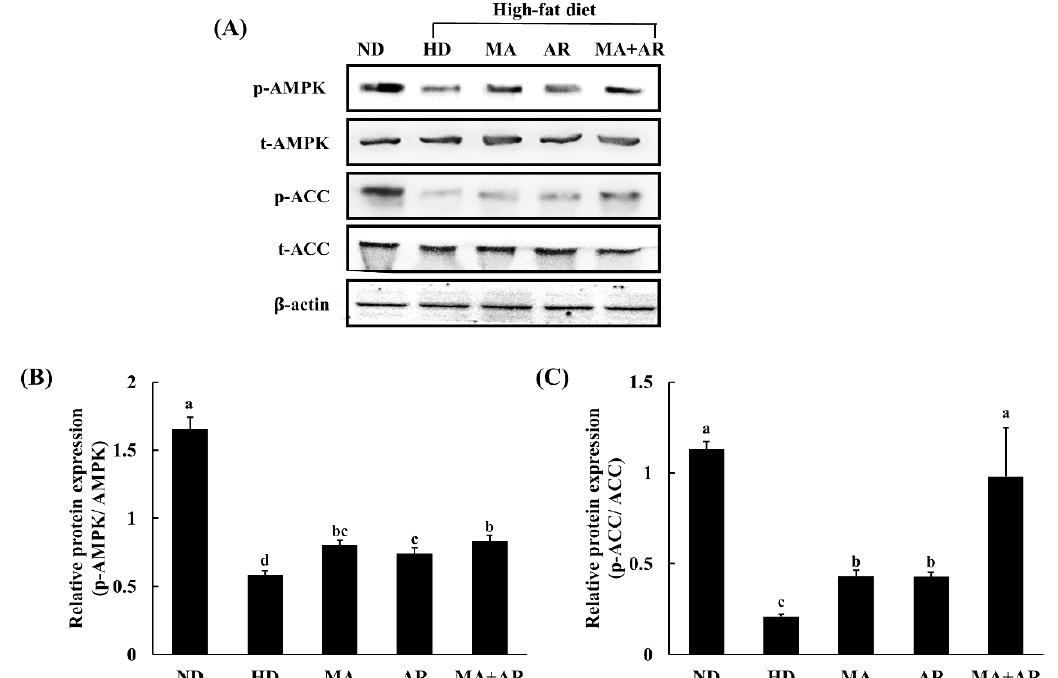
Figure 6. Proteins involved in lipid metabolism in the liver of the experimental mice. M. alba extract (400 mg/kg b.w), A. melanocarpa extract (400 mg/kg b.w) or mixture extract were orally administered to experimental mice fed a high-fat diet for 14 weeks. AMPK, adenosine monophosphate (AMP)-activated protein kinase, p-AMPK, phosphorylated AMPK, ACC, acetyl-CoA carboxylase, p-ACC, phosphorylated ACC. ( A ) Western blot, ( B ) relative expression of p-AMPK, and ( C ) relative expression of p-ACC. ND, normal diet, HD, high-fat diet, MA, high-fat diet + M. alba 400 mg/kg bw, AR, high-fat diet + A. melanocarpa 400 mg/kg bw, MA+AR, high-fat diet + mixture of M. alba and A. melanocarpa (400 mg/kg bw). Results are expressed as means ± S.D ( n = 10). Means with different superscript letters (a, b, c, d) are significantly different from each other by Duncan’s test of ANOVA at p < 0.05. “a” denotes the highest value and “d” represents the lowest value.